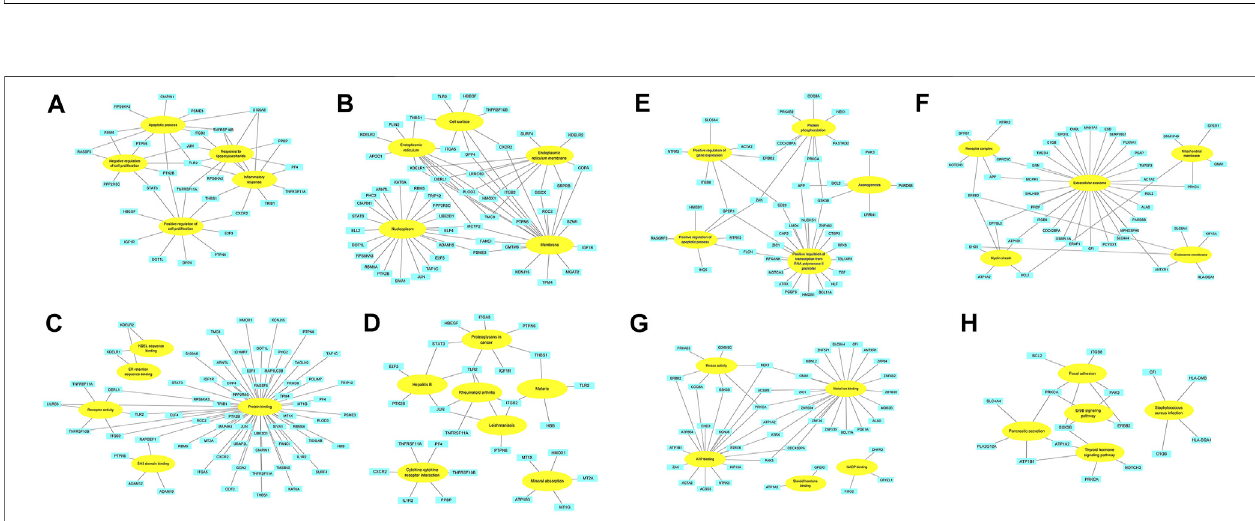
FIGURE 4 | The association between David terms and DEGs. (A – D) BP, CC, MF and KEGG enriched by up-regulated DEGs; (E – H) BP, CC, MF and KEGG enriched by down-regulated DEGs. Yellow: GO or KEGG terms; Blue: DEGs.